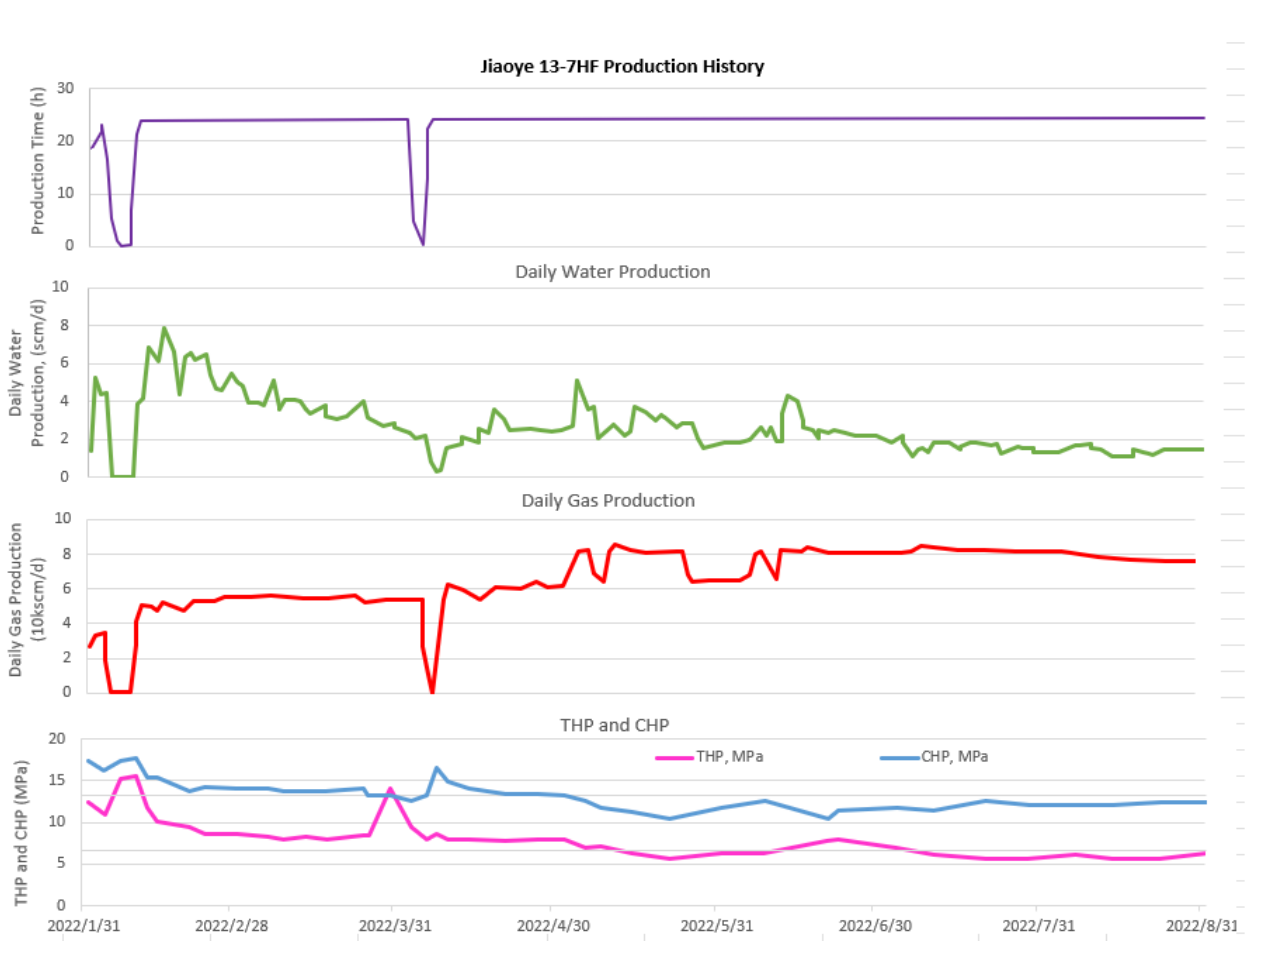
Figure 10. FL-2HF ’s production history. Figure 10. FL-2HF’s production